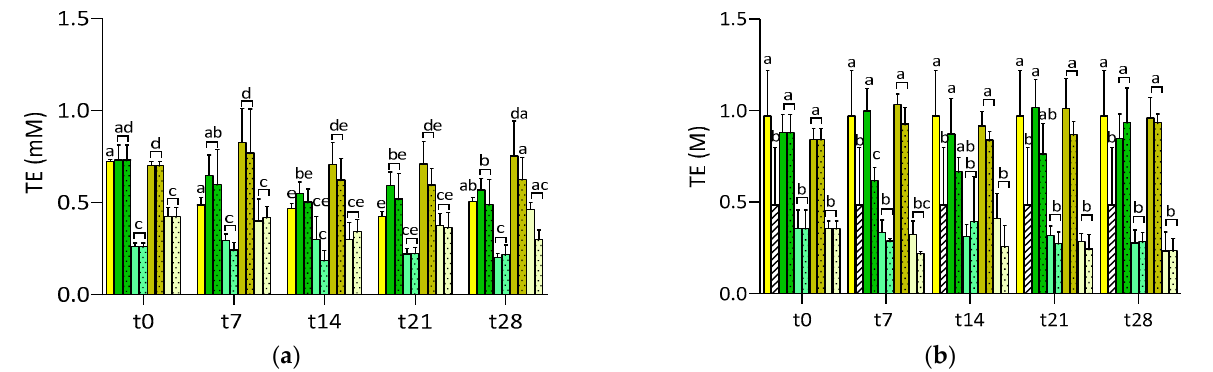
Figure 5. Radical-scavenging ability of ABTS •+ ( a ) and SO •+ ( b ) of formulated juices in RSV-juice (dark green), RSV-CA (light green), γ -CD·RSV-juices (yellowness green) and γ -CD·RSV-CA (light yellow) along time of storage, protected from light, at room temperature (rt) (without pattern) and 4 °C (pattern dots). Plain lemon juice at room temperature (yellow without pattern) and citric acid solution at room temperature (0.18 M, white with striped pattern) are represented as reference. Different letters in the same column indicate significant differences ( p < 0.05).